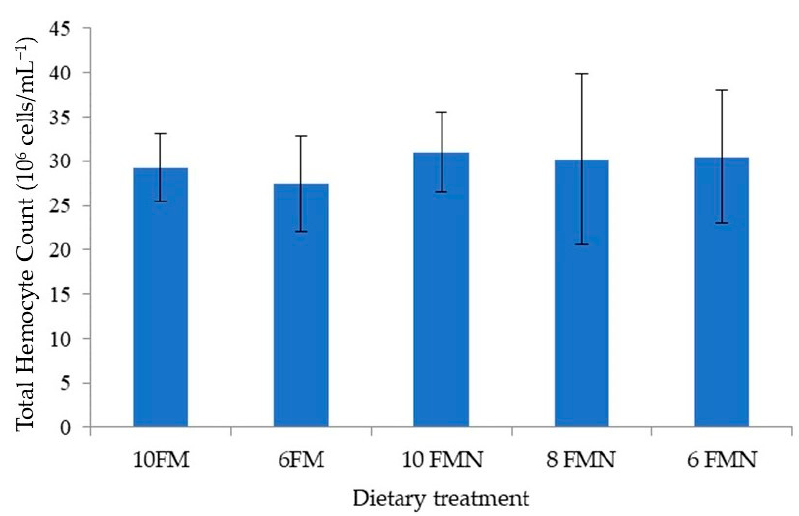
Figure 2. Pacific white shrimp (PWS) total hemocyte count (10 6 cells/mL − 1 ) at the end of the 110-day growth trial. 10FM (control group; 10% FM), 6FM (6% FM and no nucleotide supplementation), 10FMN (10% FM; 0.1% nucleotides), 8FMN (8% FM; 0.1% nucleotides) and 6FMN (6% FM; 0.1% nucleotides). Values represent the mean of ten replicates.